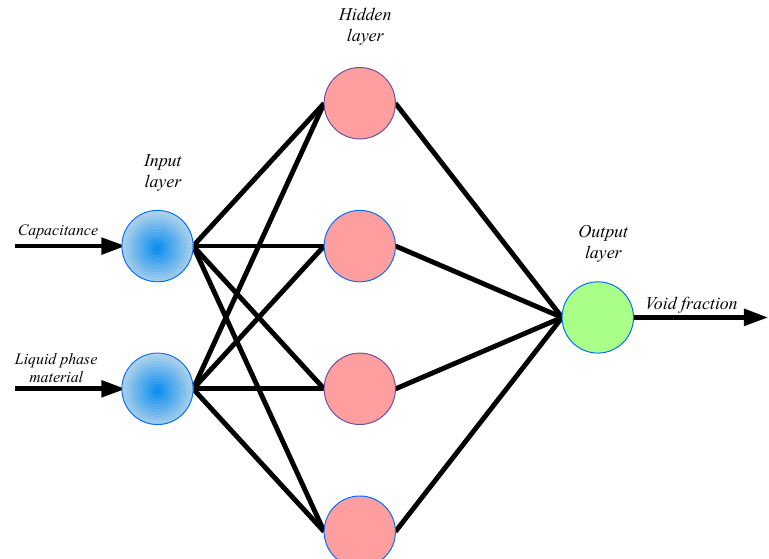
10 of 13 Figure 11. Comparison of the experimental data and the simulated data in a two-phase annular flow. 4. Artificial Neural Network ANNs are mathematical systems made up of simple processing elements called neu- rons that run parallel and can be generated as one or more layers [31]. Classification and prediction are two significant applications of ANNs. The most common ANNs are multi- layer perceptron (MLP) networks [32]. The primary attribute of this method is the ability to learn by utilizing accurate data. This model can predict behaviors and patterns using a limited number of precise data, known as the MLP’s “training set” [33]. In addition, the testing set is specified in order to evaluate the network’s accuracy and precision. The net- work has never encountered these data before. Figure 12 illustrates the presented MLP model with the capacitance of the sensor and liquid phase material as inputs and the void fraction percentages as outputs. The main characteristic of this technique is the ability to learn through validated simulated data. The data set for training the network was created using the validated simulation values. There were 38 (70%) and 17 (30%) samples for the training and testing data, respec- tively which were selected randomly. According to a prior publication [34], a presented algorithm was used to evaluate various architectures, and the best one was chosen. Actu- ally, the best structure was chosen after testing various layers, epochs, activation functions